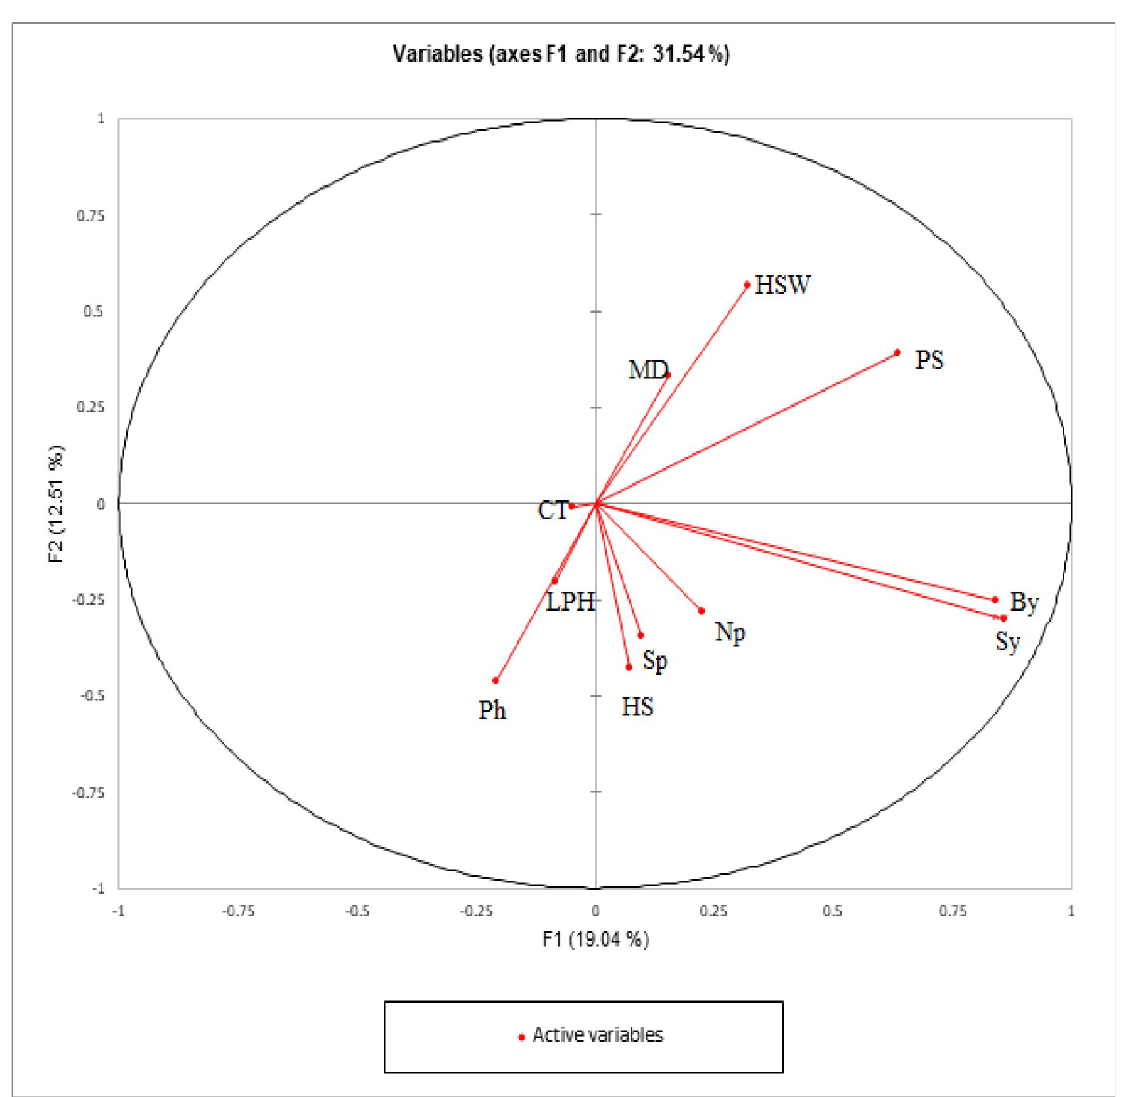
Fig 1. PCA showing the contribution of quantitative traits among 220 lentil genotypes grown in